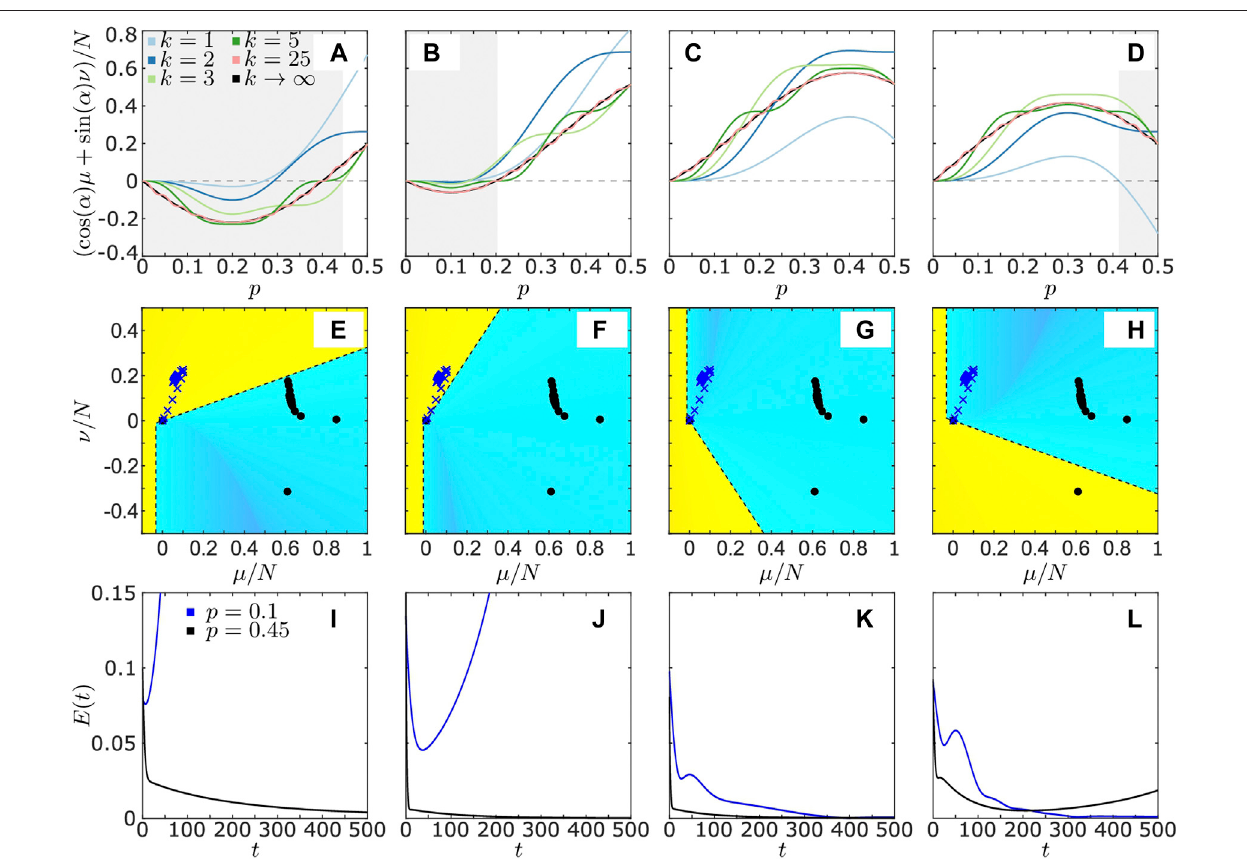
FIGURE 4 | Stability analysis of the synchronous state of system Eqs. 16 , 17 with plasticity rule Eqs. 18 – 20 and coupling structure Eq. 25 . Panels (A – D) showthefunction c 2 ( α , μ k ( p ) , ] k ( p )) fordifferent α ,see Eq.15 ,calculatedwiththeapproximations Eqs.26 , 27 dependingontherelativecouplingrange p .Ineach panel, c 2 is displayed for different values of k . The gray shaded regions refer to unstable synchronous states. Panels (e,f,g,h) show the master stability function Λ ( D g ( 0 ) μ , g ( 0 ) ] ) for the cross-section Im ( μ ) (cid:1) 0 and Im ( ] ) (cid:1) 0 for different values of α with color code as in Figure 1 . The crosses and dots correspond to two sets of eigenvalue pairs ( μ k , ] k ) ( k (cid:1) 0 , ... , N − 1) for relative coupling range p (cid:1) 0 . 1 (blue crosses) and p (cid:1) 0 . 45 (black points), respectively. Panels (I – L) show (cid:28)(cid:28)(cid:28)(cid:28)(cid:28)(cid:28)(cid:28)(cid:28)(cid:28)(cid:28)(cid:28)(cid:28)(cid:28)(cid:28)(cid:28)(cid:28)(cid:28) (cid:30) ( ϕ ( t ) − ϕ ( t )) 2 (cid:5) N the synchronization error E ( t ) (cid:1) for simulations with relative coupling range p (cid:1) 0 . 1(blue) and p (cid:1) 0 . 45(black). Each simulation is initialized at i (cid:1) 1 i 1 a slightly perturbed synchronous state. Parameters: N (cid:1) 200, ϵ (cid:1) 0 . 01, (A, E, I) α (cid:1) − 0 . 4 π , (B, F, J) α (cid:1) − 0 . 2 π , (C, G, K) α (cid:1) 0 . 2 π , (D, H, L) α (cid:1) 0 . 4 π